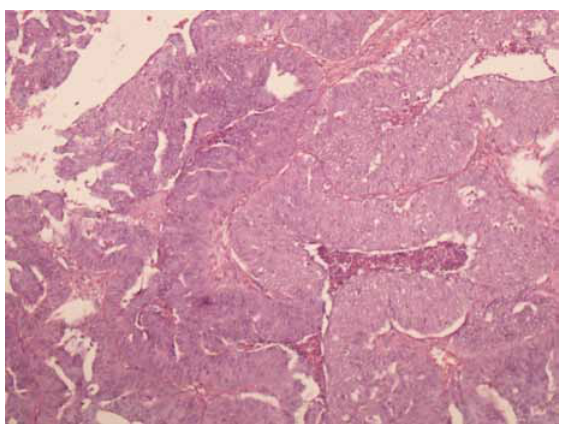
Figure 3. Nests of papillary arranged atypical cells in malignant Brenner tumor